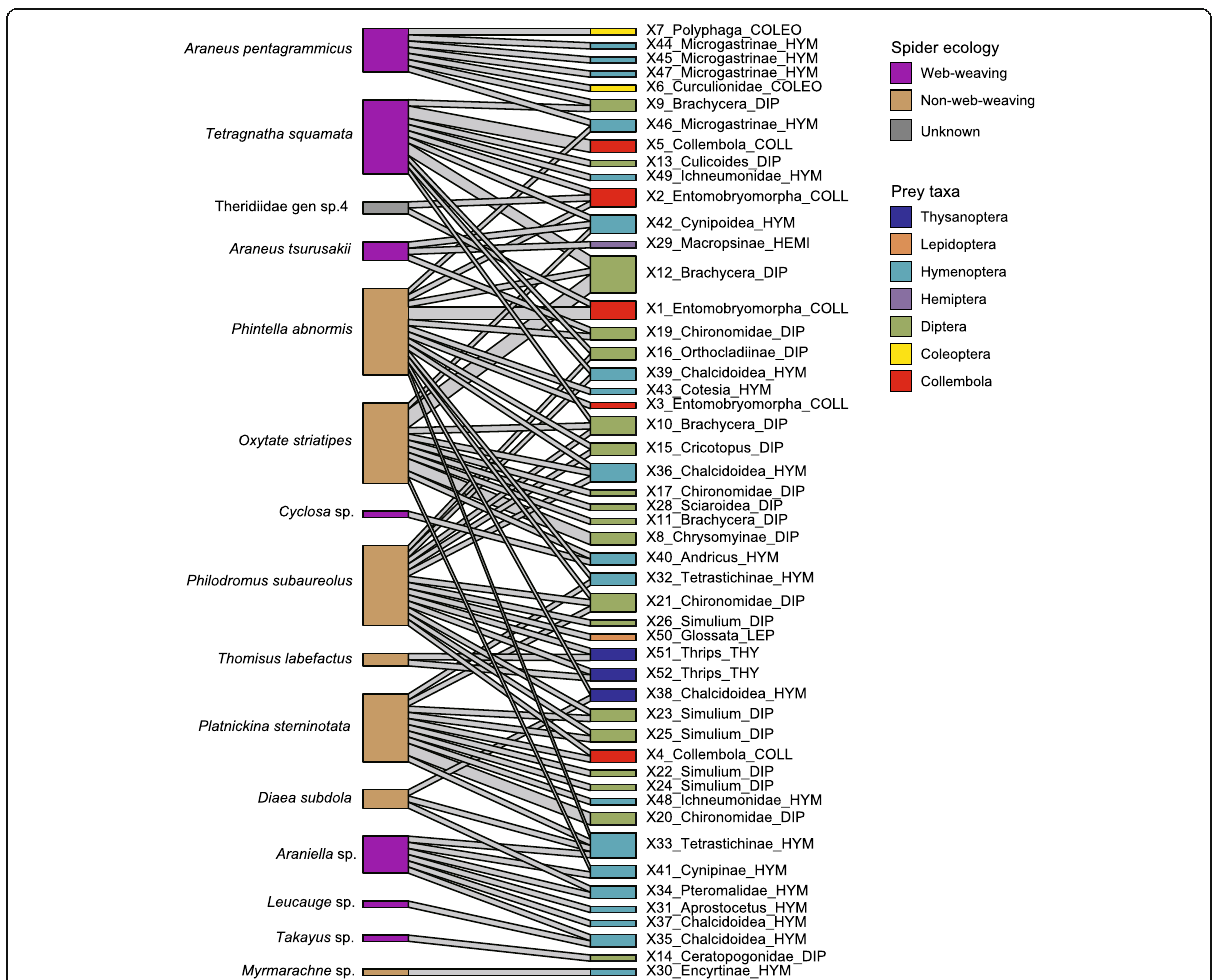
Fig. 4 Food-web structure. Spider species (left) are linked to the Hexapoda OTUs (right) detected. The results of all the four PCR settings were combined. Web-weaving and non-web-weaving spiders are indicated by color. The thickness of the link represents the number of spider samples from which a focal spider – Hexapoda association was observed. The lowest taxonomic rank indicated by the automatic molecular identification is shown for each prey OTU, followed by the abbreviation of order-level taxonomy (Additional file 6). Box size represents the number of samples. COLL, Collembola; COLEO, Coleoptera; DIP, Diptera; HEMI, Hemiptera; HYM, Hymenoptera; LEPI, Lepidoptera; THY,